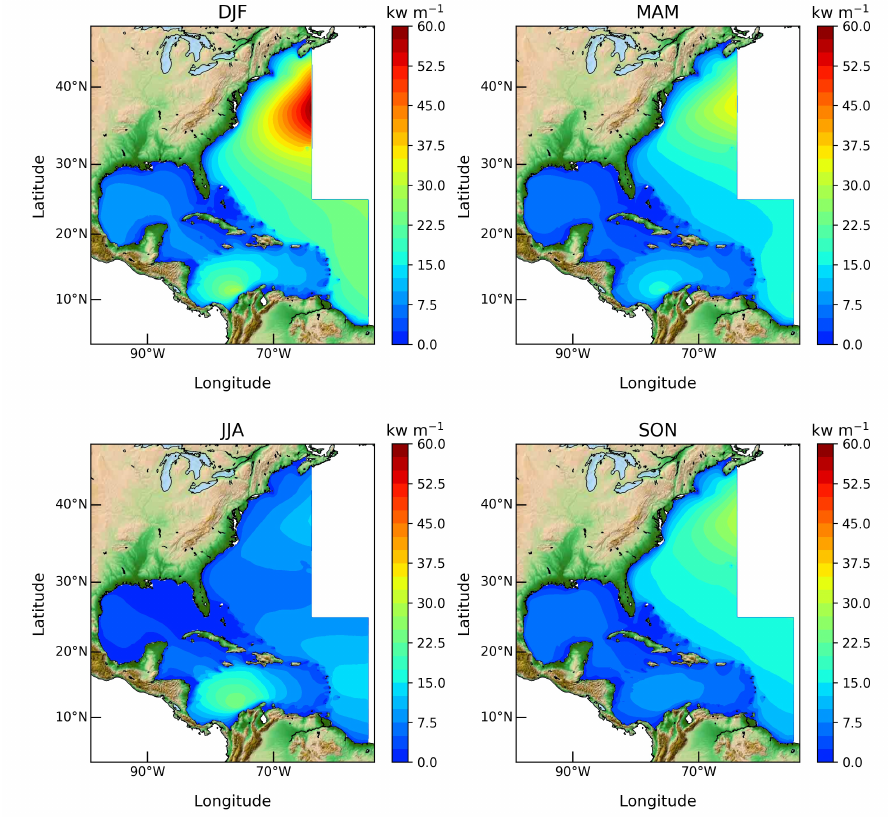
Figure 4. Seasonal evolutions of the mean available wave energy flux in the North-West Atlantic, the Gulf of Mexico and the Caribbean Sea over the period 1979–2009 (DJF = December–January–February, MAM = March–April–May, JJA = June—July–August, SON = September–October–November) adapted from